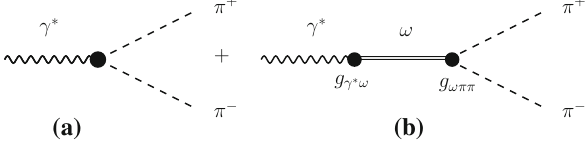
Fig. 1 Diagrammaticrepresentationofthereaction γ ∗ → π + π − .The pions from both diagrams undergo final-state interactions that are not shown explicitly